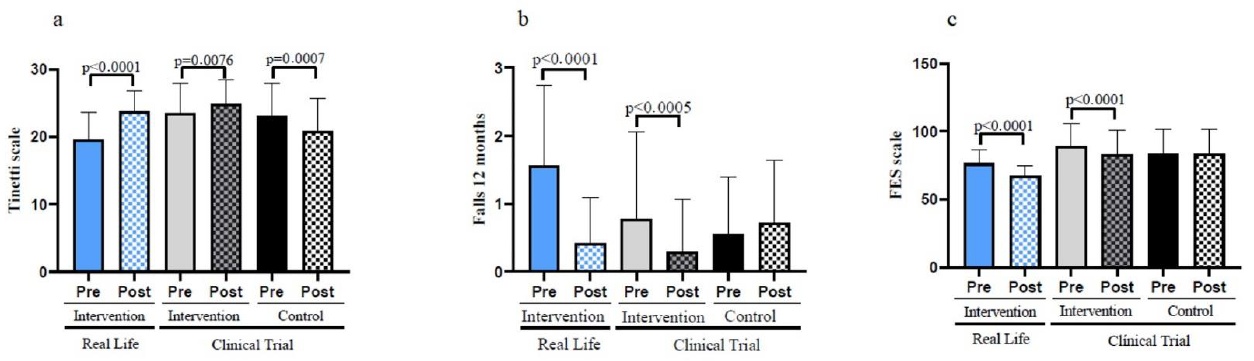
Figure 4. Fall risk, number of falls and fear of falling assessed in old individuals before and after a six-month intervention. ( a ) Assessment of the Tinetti scale. ( b ) Number of falls before and after the Real-Life and the Clinical Trial interventions. ( c ) Fear of falling before and after the Real-Life and the Clinical Trial intervention. Real-Life Intervention n = 50, Clinical Trial Intervention n = 51, Clinical Trial Control n = 49. Bars represent mean ± SD. Statistical analysis was performed with the Student’s t test for paired samples and the Wilcoxon test for non-parametric samples.